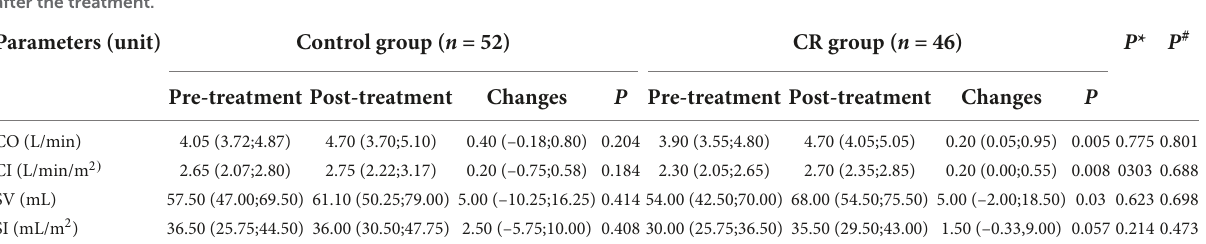
TABLE 4 Comparisons of parameters of cardiac output measured by impedance cardiography of patients with CHD and AHF before and after the treatment.